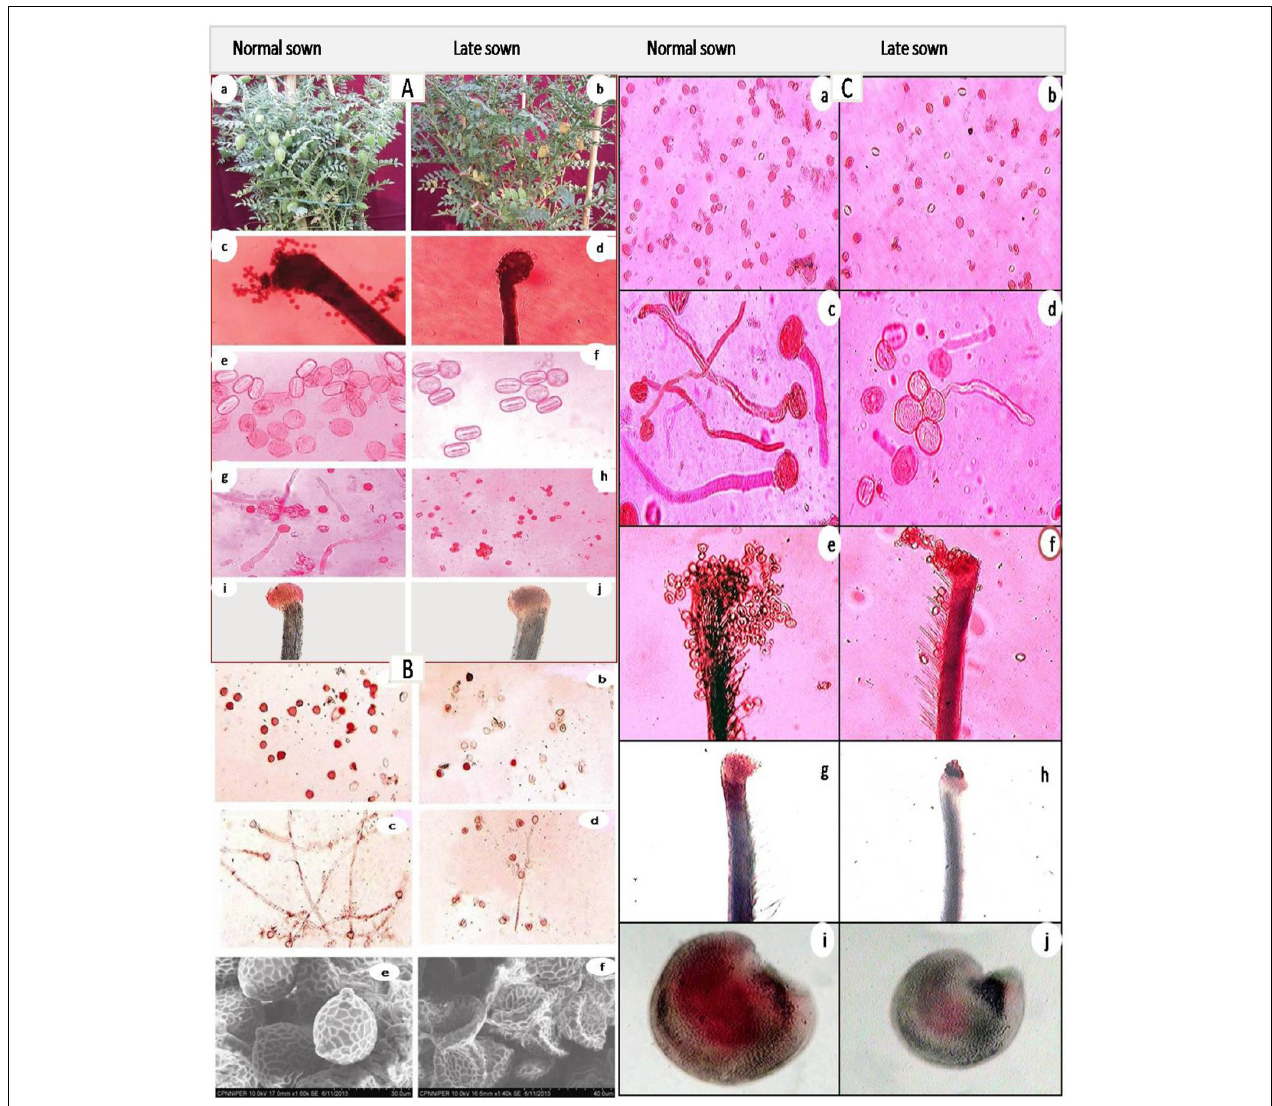
FIGURE 5 | Effect of heat stress in normal-sown and late-sown (heat-stressed) plants Chickpea [( A : Biomass in control (a) and heat-stressed (b), Pollen load in control (c) and heat-stressed (d), Pollen viability in control (e) and heat-stressed (f) pollen viability in control (g) and heat-stressed (h), Stigm receptivity in control (i)